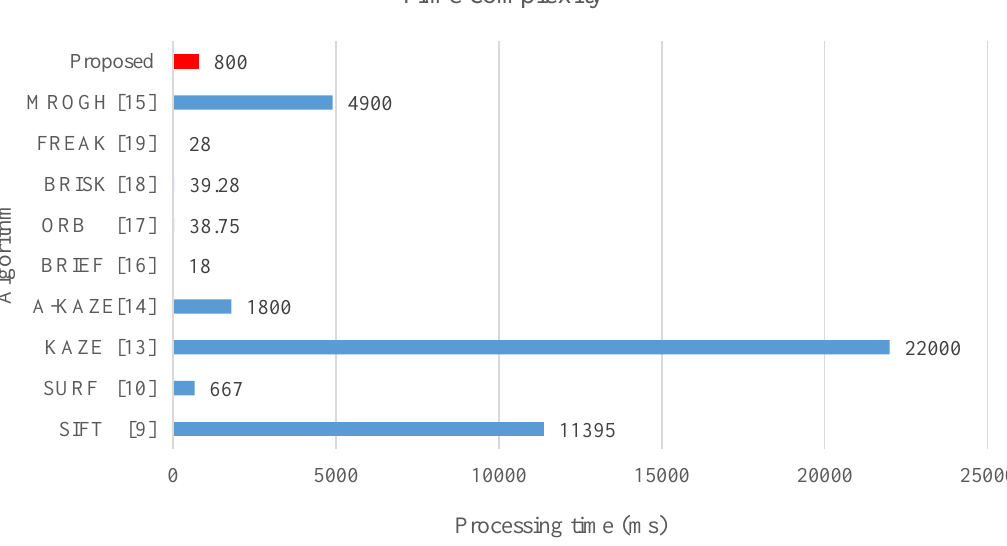
Figure 24. Average processing time of various local stable feature matching algorithms.